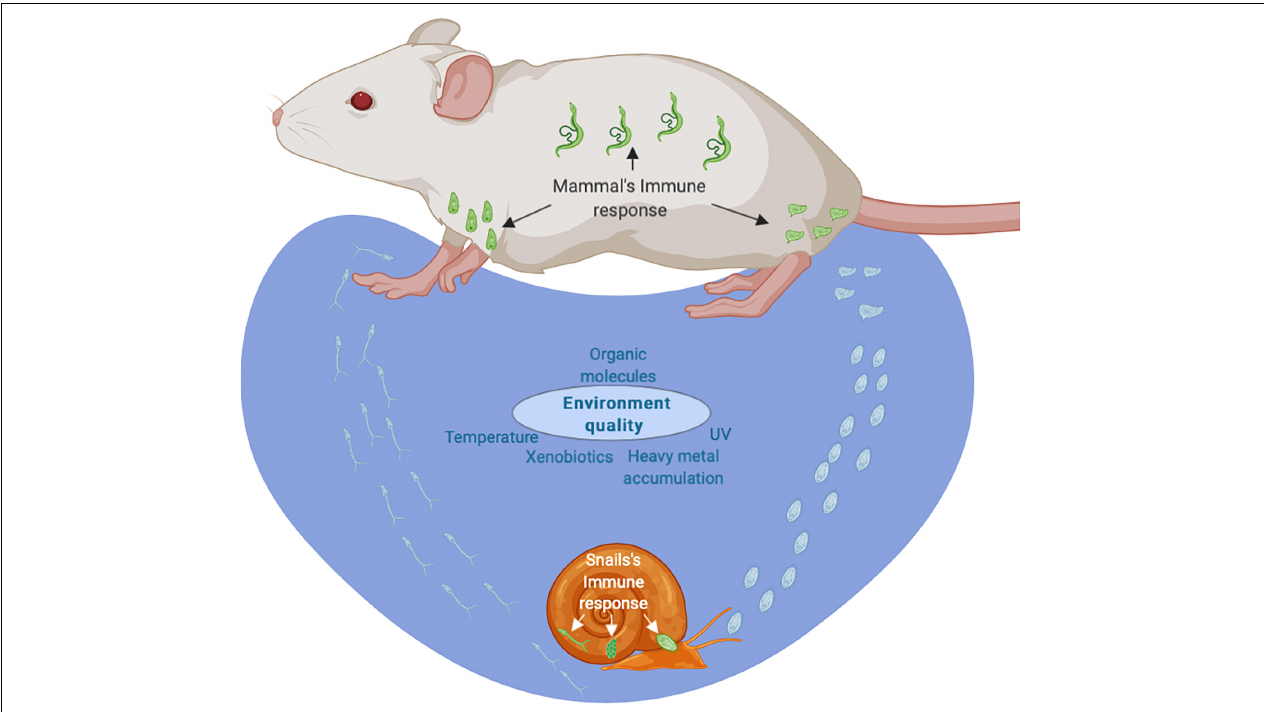
FIGURE 1 | Life cycle of the human parasite Schistosoma mansoni . The life cycle starts when eggs (in green) are released by mammalian’s host and are affected by osmotic pressure in contact with freshwater (in blue) and deliver a free-swimming larva, the miracidium, that seek out an intermediate host, a freshwater snail of the Biomphalaria genus. Here, as a free-swimming larva, is the first time that the parasite is susceptible to an abiotic environment (in blue). After this first, miracidia have to penetrate the tegument of the snail host (in green) and transform into primary sporocysts while dealing with a sophisticated immune system with barrier functions in the epithelium, a cellular immune response and a humoral defense response. Cercariae (in green) are realized and it is the second time that schistosomes face water quality (in blue). Cercaria larva actively seek a definitive mammalian host (rodent, primate or human). After infection, schistosomules migrates through the venous environment to develop into adult parasites and to reproduce sexually while dealing with humoral and cellular immune responses. In blue – eggs and free-swimming stages under cues of the water environment. In green – parasitic stages under cues from the internal environment of the